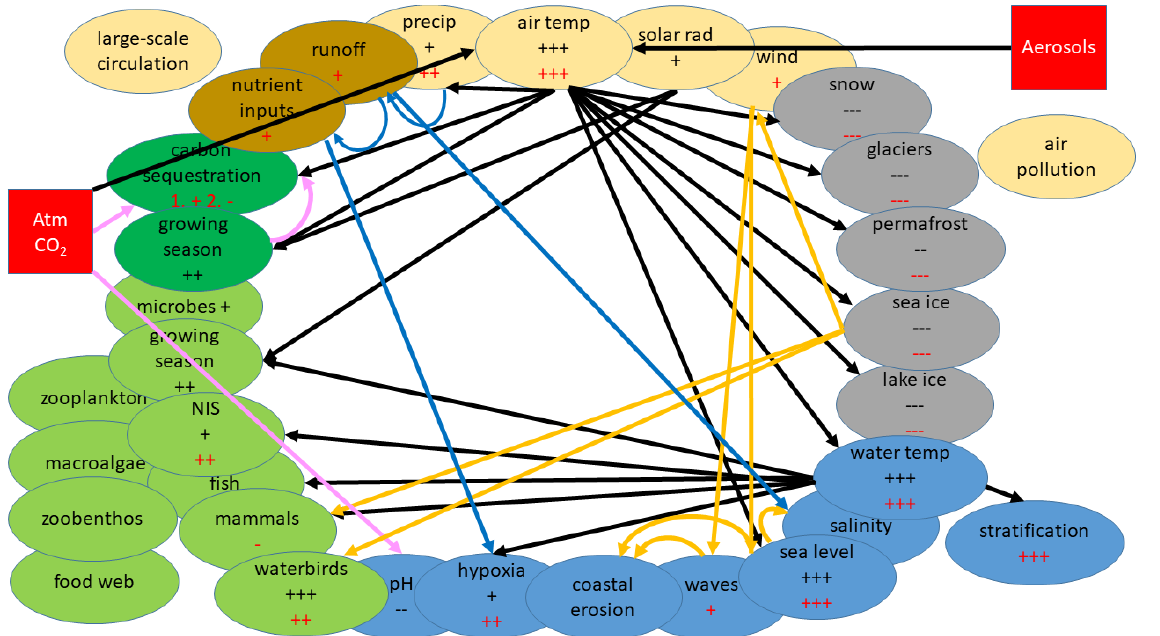
Figure 35. Synthesis of the knowledge on present and future climate changes. Shown are the anthropogenic climate changes in 33 Earth system variables (bubbles) of the atmosphere (yellow), land surface (brown), terrestrial biosphere (dark green), cryosphere (grey), ocean and sediment (blue), and marine biosphere (light green). The abbreviation NIS stands for non-indigenous species. The sign of a change ( + / − ; plus/minus) is shown together with the level of confidence denoted by the number of signs, i.e. one to three signs corresponding to low, medium, and high confidence levels, as the result of the literature assessment reflecting consensus and evidence following the IPCC definitions (Sect. 2.3). Sign colours indicate the direction of past (black) and future (red) changes, following Table 15. Uncertain changes ( + / − ) are not displayed. Investigated external anthropogenic drivers of the Earth system are shown as red squares, i.e. greenhouse gases, in particular CO 2 , and aerosol emissions. The prevailing climate change attribution relationships with sufficiently high confidence are shown by arrows (black is the heat cycle, blue is the water cycle, orange is the momentum cycle, including sea level changes, and pink is the carbon cycle). Projections of carbon sequestration of Arctic terrestrial ecosystems for the 21st century first showed increased uptake and later a carbon source (Sect. 3.3.3), which is denoted by “1. + 2. − ”. Future changes in mean sea level will be dominated by the thermal expansion of the global ocean and melting of ice sheets outside the Baltic Sea region. The impact of regional changes are probably